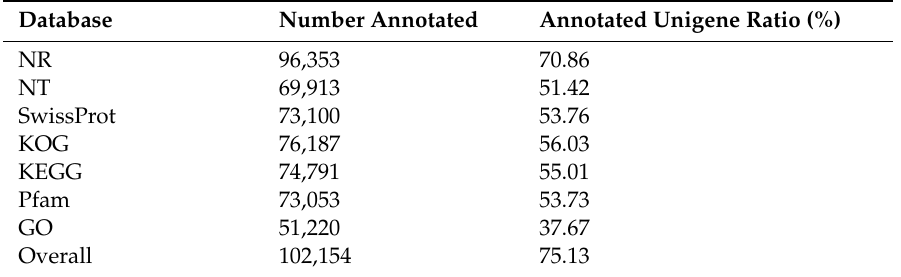
Table 1. Summary statistics of annotations for C. chinense unigenes via seven public databases.